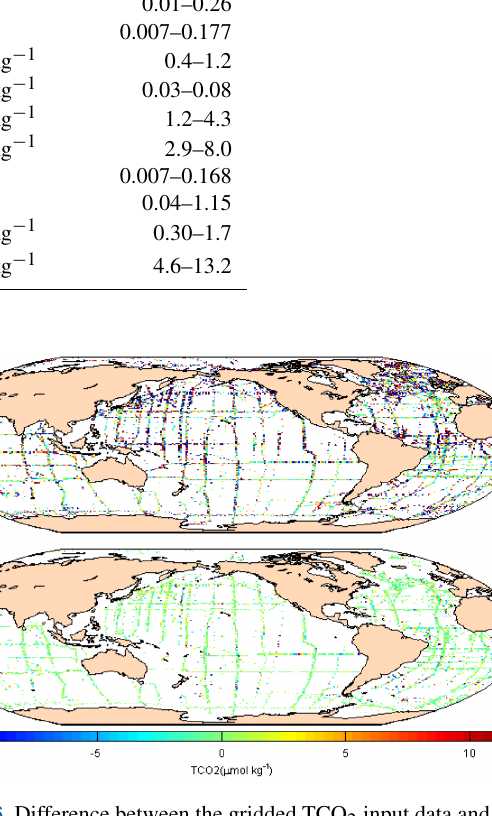
Figure 6. Difference between the gridded TCO 2 input data and the mapped climatologies at 10m (a) and 3000m (b)